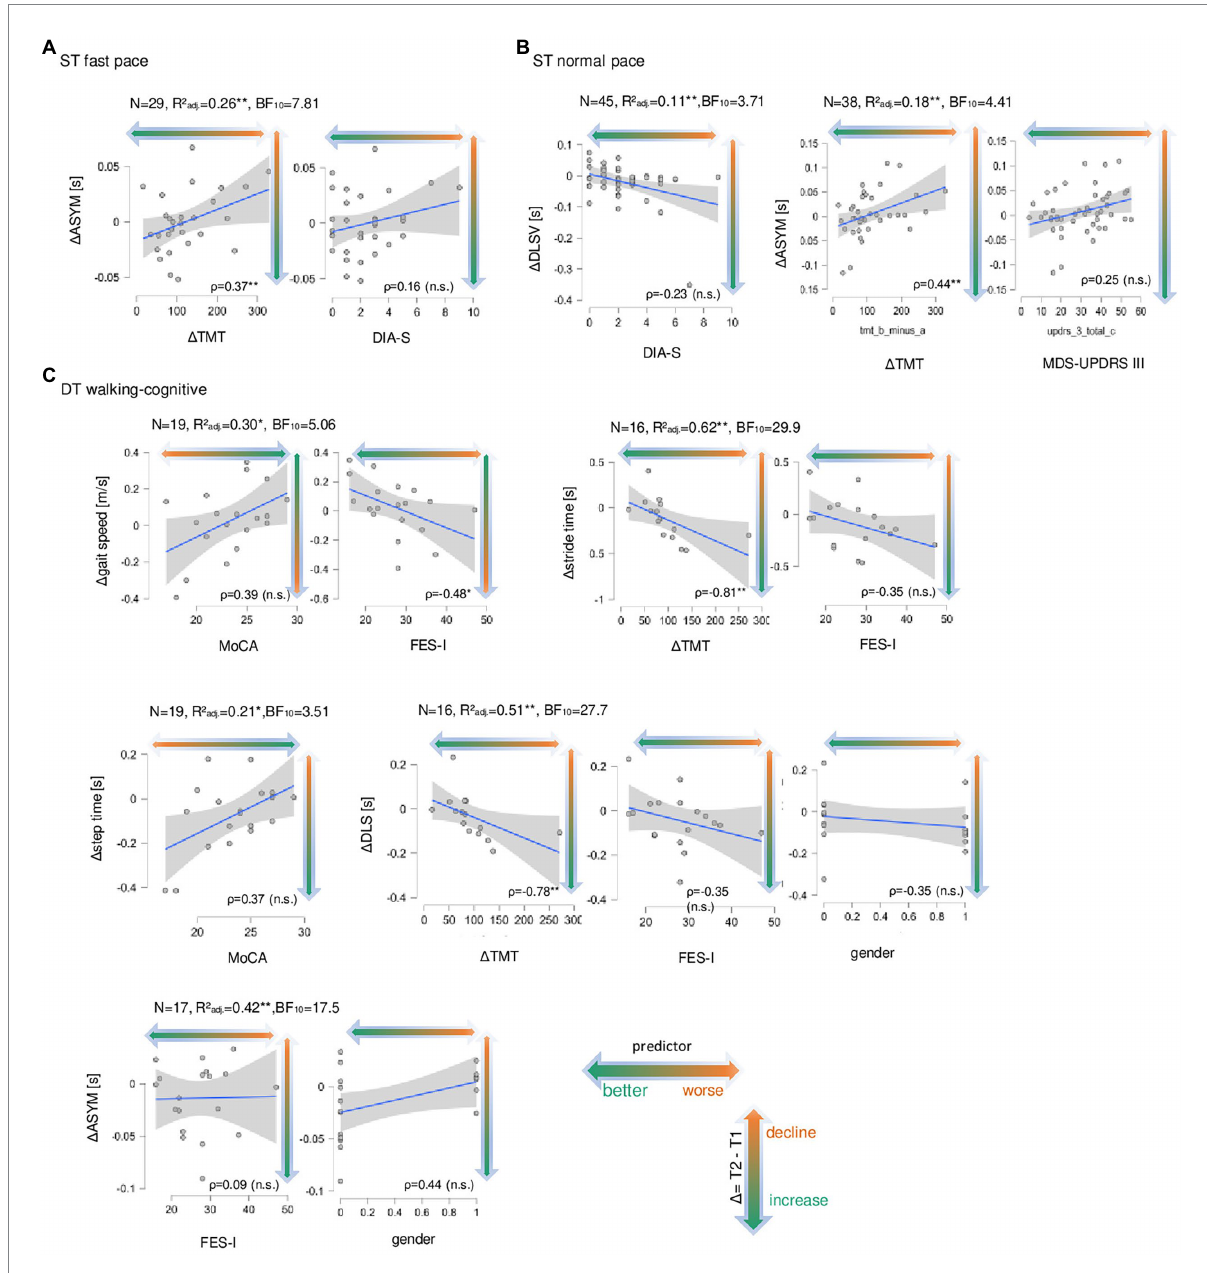
FIGURE 2 Correlation plots of the significant Regression models with the relevant model predictors for change in walking parameters. In (A) for single task fast pace walking condition (ST fast pace) the change (delta of measurement point T1 minus measurement point T2, Δ ) in asymmetry (ASYM, in seconds, s) is shown on the ordinates, the delta of Trail Making Test (part B minus part A, Δ TMT, s) and the total score of the Depression im Alter- Scale (DIA-S) are on the abscissas. Sample size N is given as well as the adjusted coefficient of determination R 2 adj , Bayes factor BF 10 and Spearman’s rank correlation ( ρ ) between Δ ASYM and Δ TMT and between Δ ASYM and DIA-S, significant correlation coefficients are marked with * (level of significance p ≤ 0.05) and ** (level of significance p p ≤ 0.01), non-significant ones are marked with (n.s.). Data points (gray dots), regression lines with confidence intervals (blue lines with surrounding gray boxes) are shown for the Δ walking parameter. The colored direction of the arrow indicated the direction of the change in walking parameters from T2 to T1 from longer/slower (orange) to shorter/faster (green). In (B) the same is shown for single task normal pace walking condition for the change in double limb support variability ( Δ DLSV,s) with DIA-S as well as for Δ ASYM (S) and Δ TMT and the total score of the Movement Disorder Society-revised version of the motor part of the Unified Parkinson’s Disease Rating Scale (MDS-UPDRS III). In (C) the same is shown for DT motor-cognitive walking condition (DT walking-cognitive) for Δ gait speed (in meter per seconds, m/s) and the total score of the Montreal cognitive Assessment (MoCA), for Δ stride time (s) and Δ TMT and the total score of the Falls- Efficacy-Scale-International version (FES-I), for Δ step time (s) and MoCA, for Δ double limb support (DLS, s) and Δ TMT, FES-I and gender (“1,” female) as well as for Δ ASYM (s), and FES-I and